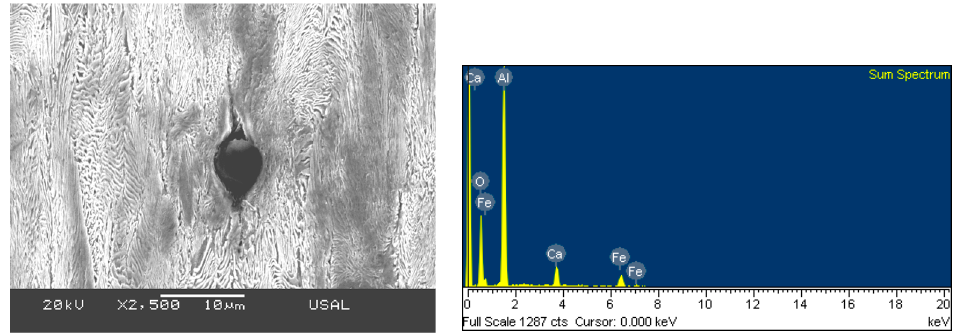
Figure 3. Inclusion of hard -type, with complex oxide composition, present in the commercial pre- stressed wire E7.